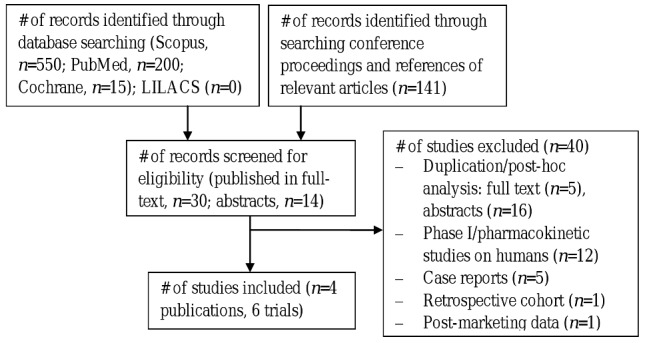
Flow diagram of the selection process of the included studies.